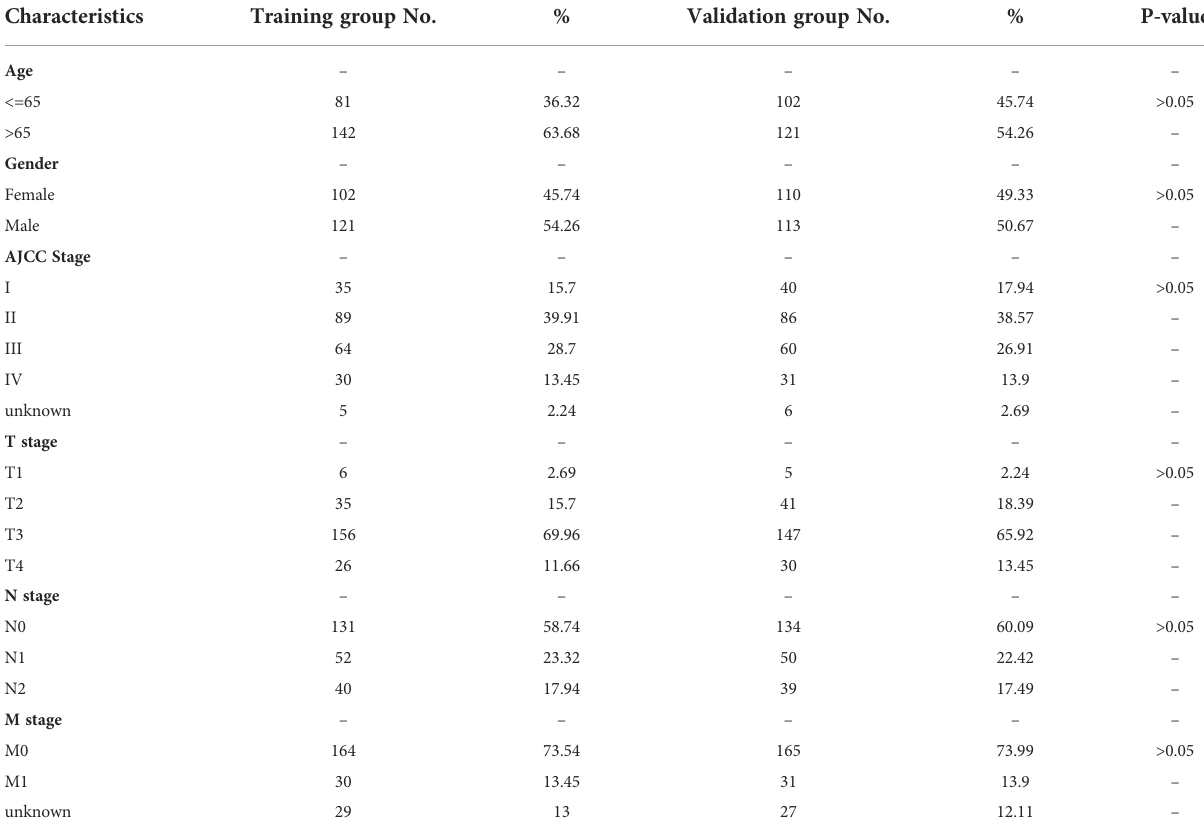
TABLE 2 The clinical characteristics of colon cancer patients in the training and validation group. Characteristics Training group No. % Validation group